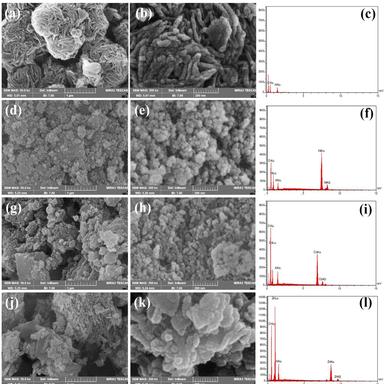
FESEM image with EDX spectroscopy of (a, b, c) Al-Fum MOF (1 µm, 200 nm), (d, e, f) NiAl-LDH (1 µm, 200 nm), (g, h, i) CoAl-LDH (1 μ, 200 nm), and (j, k, l) ZnAl-LDH (1 µm, 200 nm) particles.